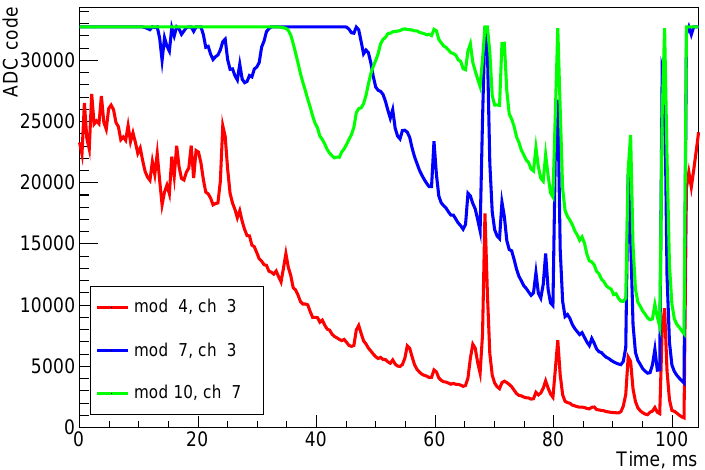
Figure 9. Waveforms of three pixels in the event registered on 27 June 2016, above India (25.3 ◦ S, 77.8 ◦ E).